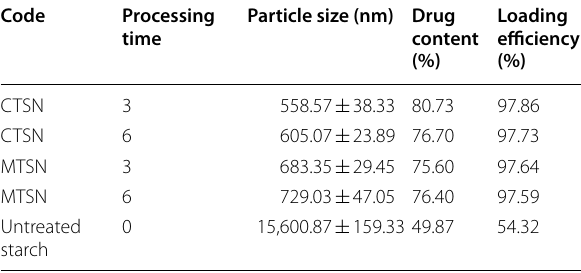
Table 2 Water absorption capacity and solubility of untreated and treated starch (mean